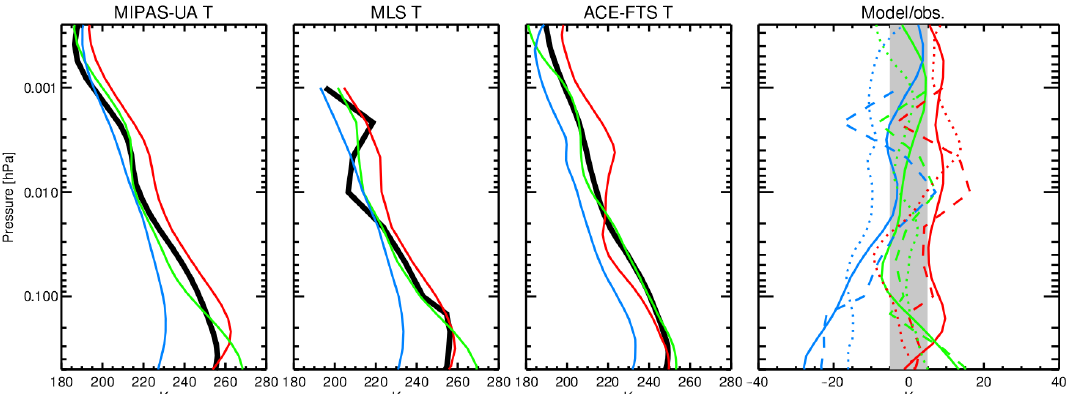
Figure 5. Comparison of observed polar mid-winter temperature mean profiles (thick black lines) to 3dCTM (blue), HAMMONIA (green), and WACCM (red). Right panel: temperature difference of the simulations and MIPAS-UA (solid), MLS (dashed), and ACE-FTS (dotted) observations. The grey shaded area indicates the ± 5K range. Data have been averaged over 70–90 ◦ N and 5 December 2008–12 January 2009 (60–90 ◦ N and 5 November 2008–12 January 2009 in the case of